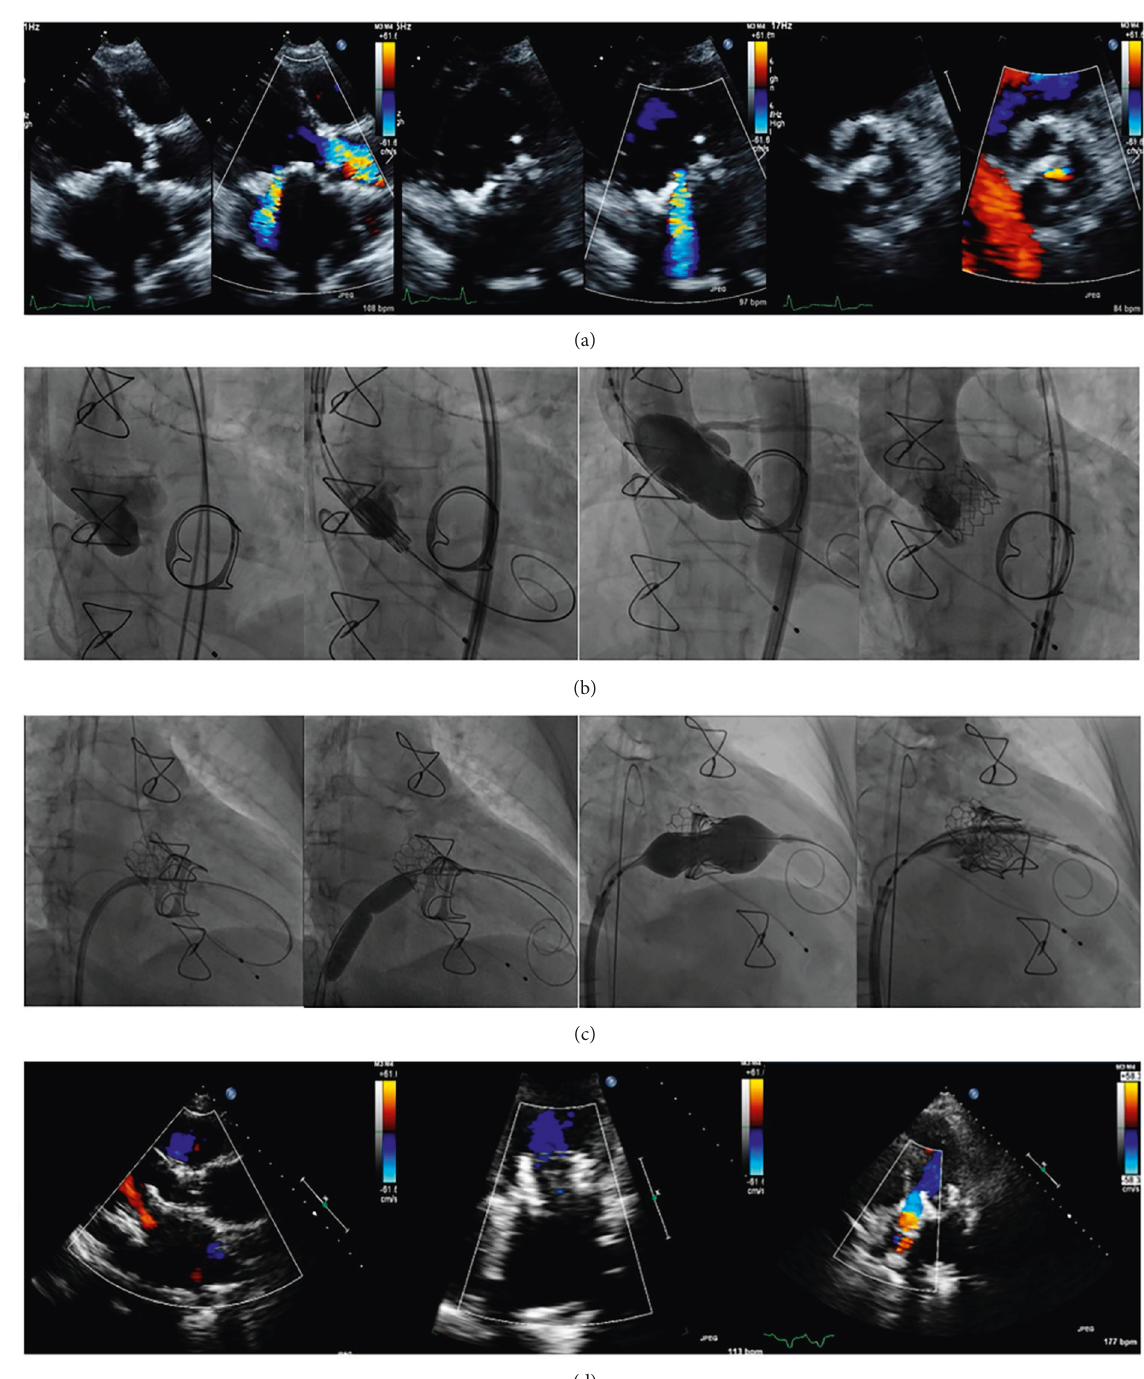
Figure 1: Transcatheter mitral valve in a degenerated Carpentier–Edwards (Edwards Lifesciences) valve (TMViV) with a concomitant transcatheter aortic valve implantation (TAVI). A 64-year-old, diabetic, hypertensive female patient, with COPD and renal transplant, had a degenerated bioprosthetic 29mm Carpentier–Edwards MV and a degenerated calcific AV with an associated AF. (a) TTE shows a degenerated bioprosthetic MV (severe MS and severe MR) with a calcific degenerated AV (severe AS and mild AR). (b) Fluoroscopy shows a transaortic TAVI of an Edwards SAPIEN-3 23mm valve during rapid pacing. (c) Fluoroscopy shows an 8.5F-agilis ™ sheath including a 5F- MP catheter over a 0.035-inch curved Terumo guidewire to cross the degenerated bioprosthetic MV to the LV, and then to the aorta. Balloon dilatation of the transseptal puncture using a 14mm balloon over a 0.035-inch/260 extra-stiff Confida ™ guidewire. Transseptal TMViV of an Edwards SAPIEN-3 29 mm valve. (d) TTE: both SAPIEN-3 valves are in mitral and aortic positions with normal flow across both valves. AF: atrial fibrillation, AR: aortic regurgitation, AS: aortic stenosis, AV: aortic valve, AVA: aortic valve area, COPD: chronic obstructive pulmonary disease, LV: left ventricle, MR: mitral regurgitation, MS: mitral stenosis, MV: mitral valve, MVA: mitral valve area, Pg: pressure gradient, TAVI: transcatheter aortic valve implantation, TMViV: transcatheter mitral valve-in-valve, and TTE: transthoracic